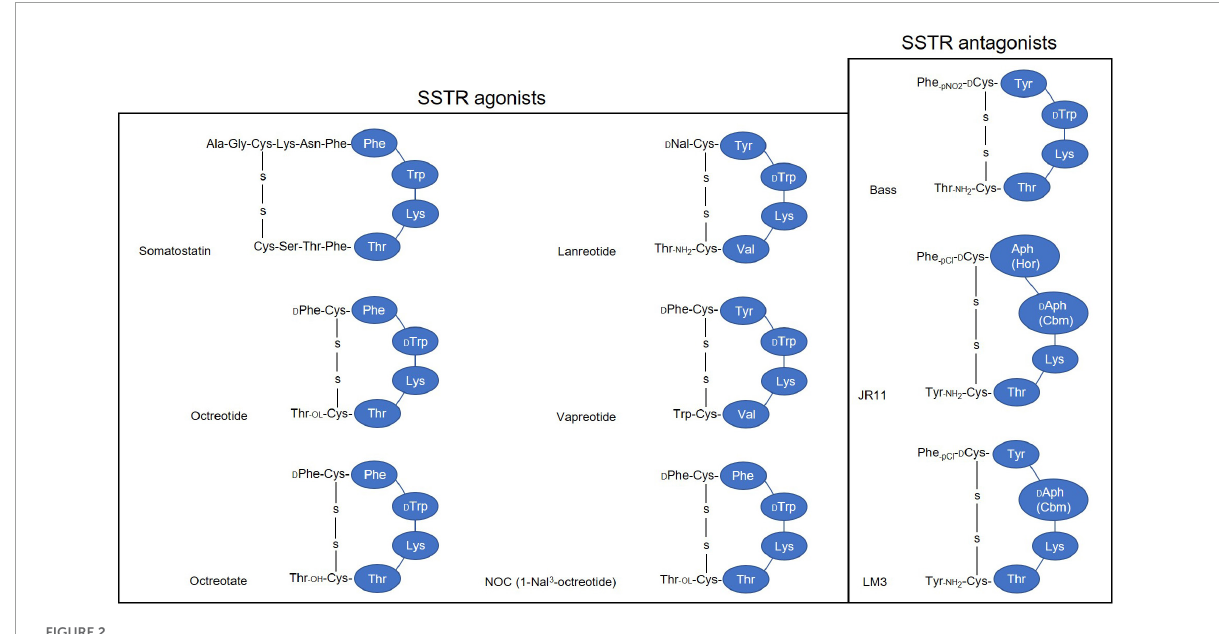
FIGURE2 Simplified illustration of somatostatin receptor agonists and antagonists. 1-Nal, naphthyl-alanine; Aph(Hor), 4-amino-L-hydroorotyl -phenylalanine; D-Aph(Cbm), D-4-amino-carbamoyl-phenylalanine.